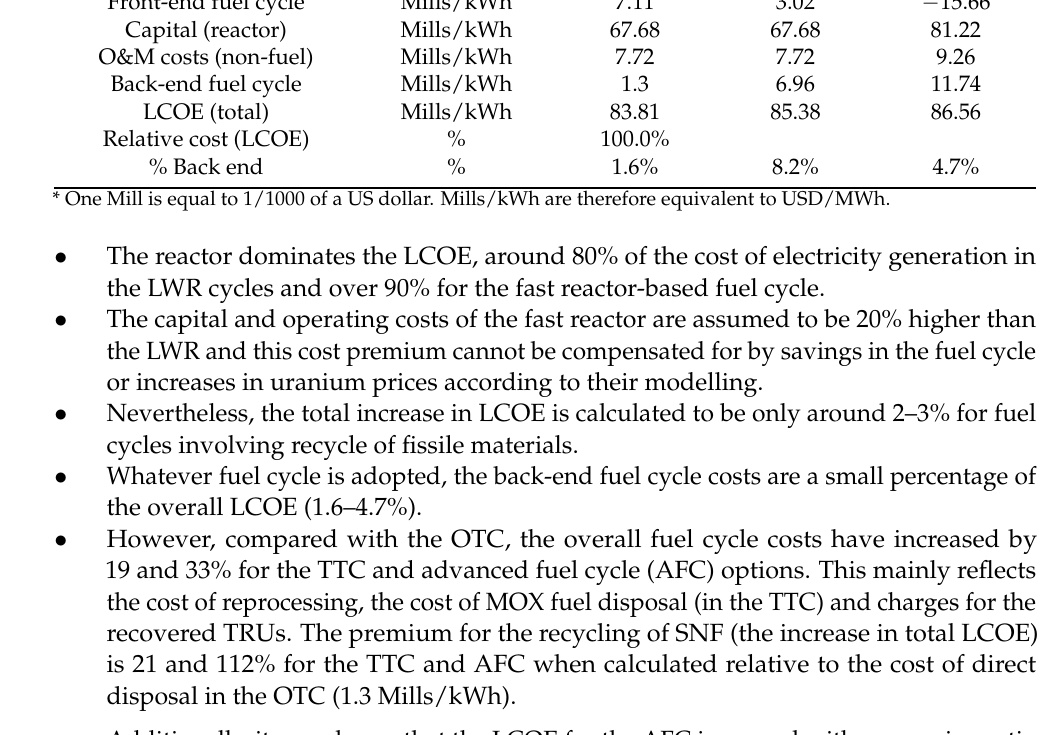
Table 4. LCOE data for fuel cycle options calculated in the MIT fuel cycle study [28]. Fuel Cycle